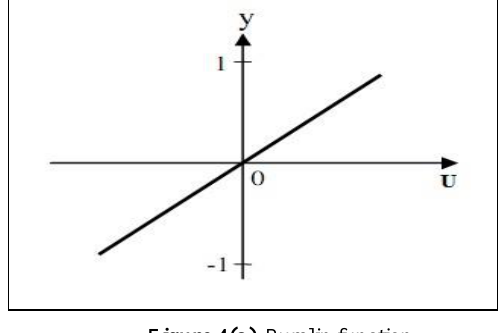
Figure 5. Structure of ANN used for wind energy plantation